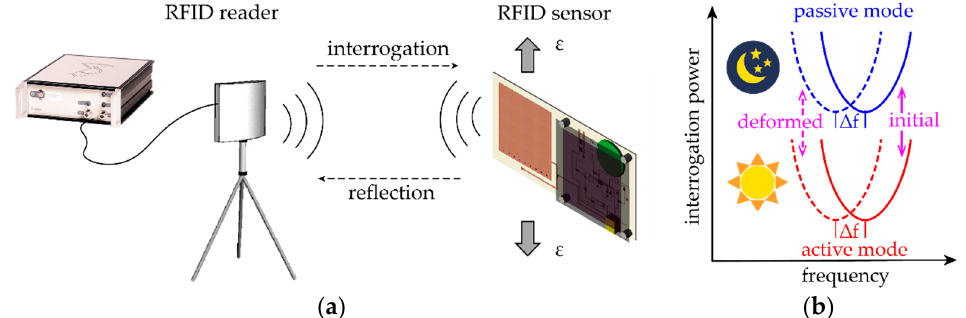
Figure 4. Illustration of the wireless sensing system for the patch antenna sensor: ( a ) wireless sensing system, ( b ) interrogation power curve. system, ( b ) interrogation power